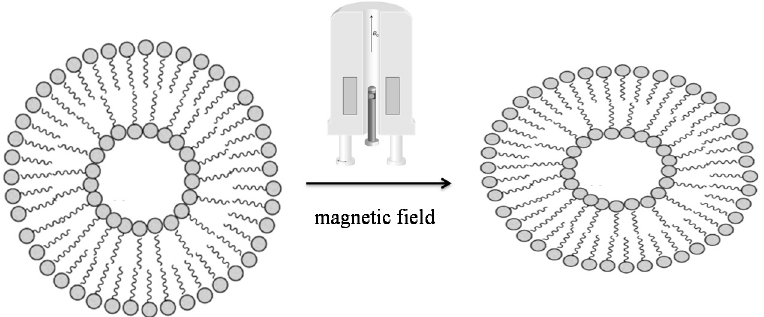
Figure 10. Representative scheme of the SdS / CPB vesicles deformation in the magnetic field.